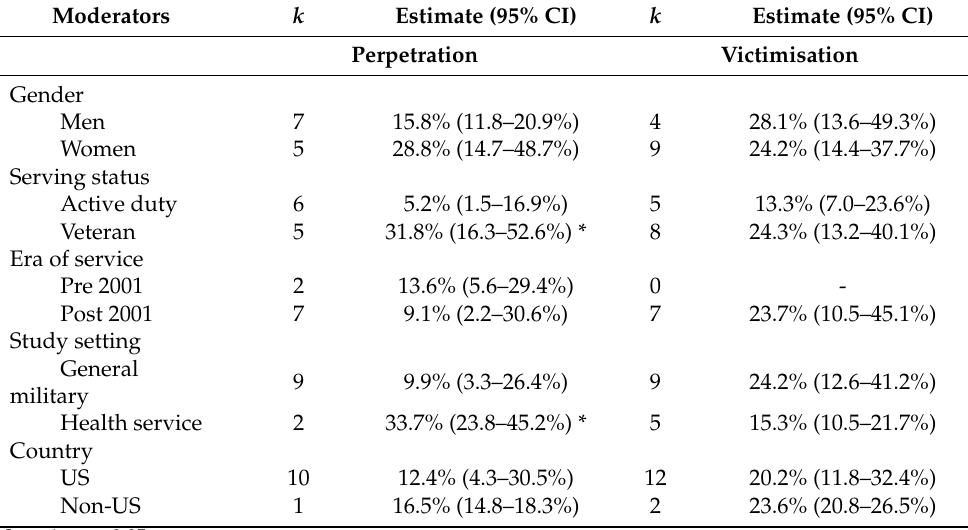
Table 3. Subgroup analyses for studies of any recent IPV perpetration and